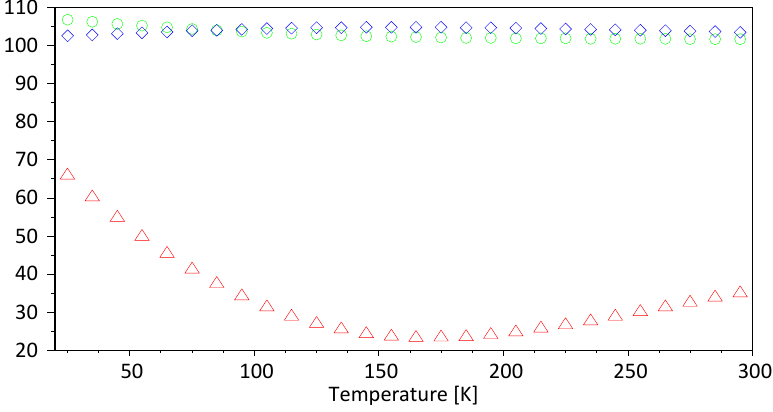
Figure 6. Variation of the angle between eigenvector EV2 and a (triangles), b (spheres) and c (rhombs) for the T-range from 20 to 300 K.